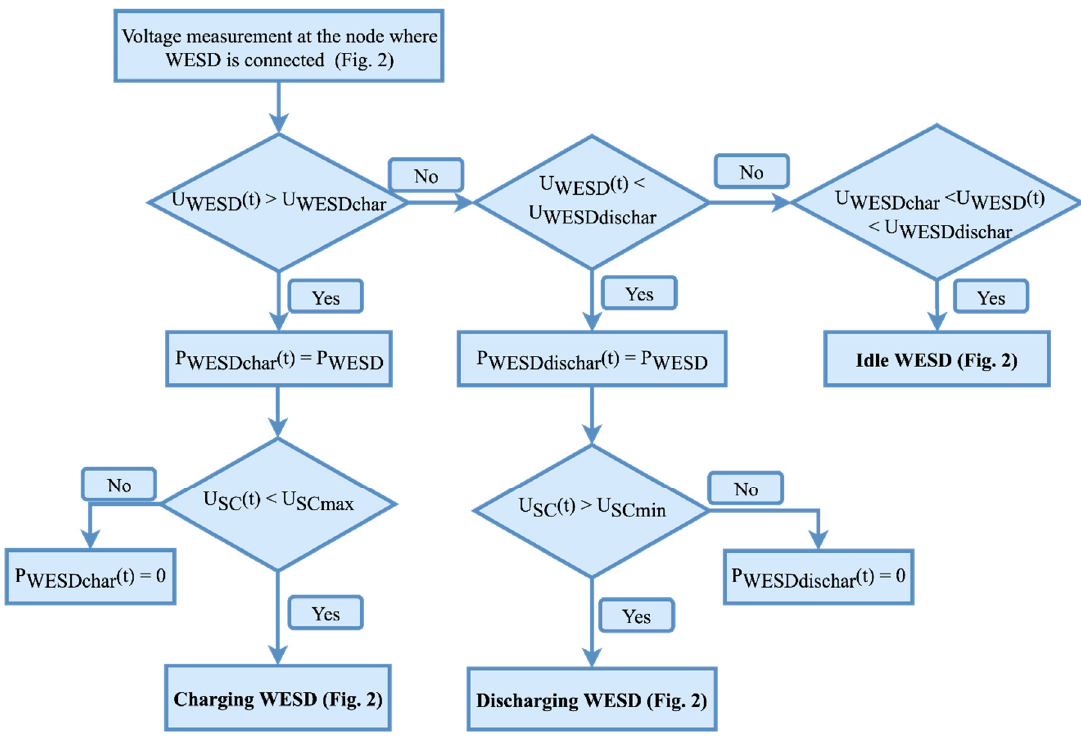
Figure 3. Flowchart of the WESD with SC control.